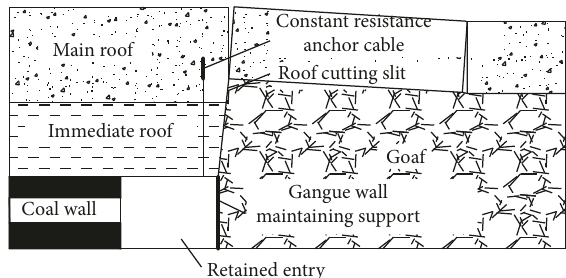
Figure 1: Principle of RCPRGER